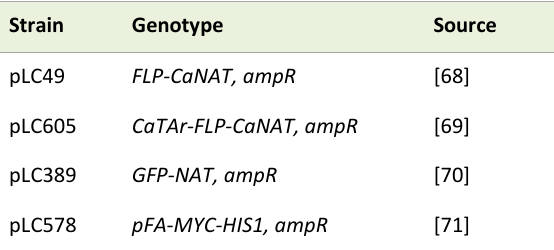
TABLE 2. Plasmids used in this study.